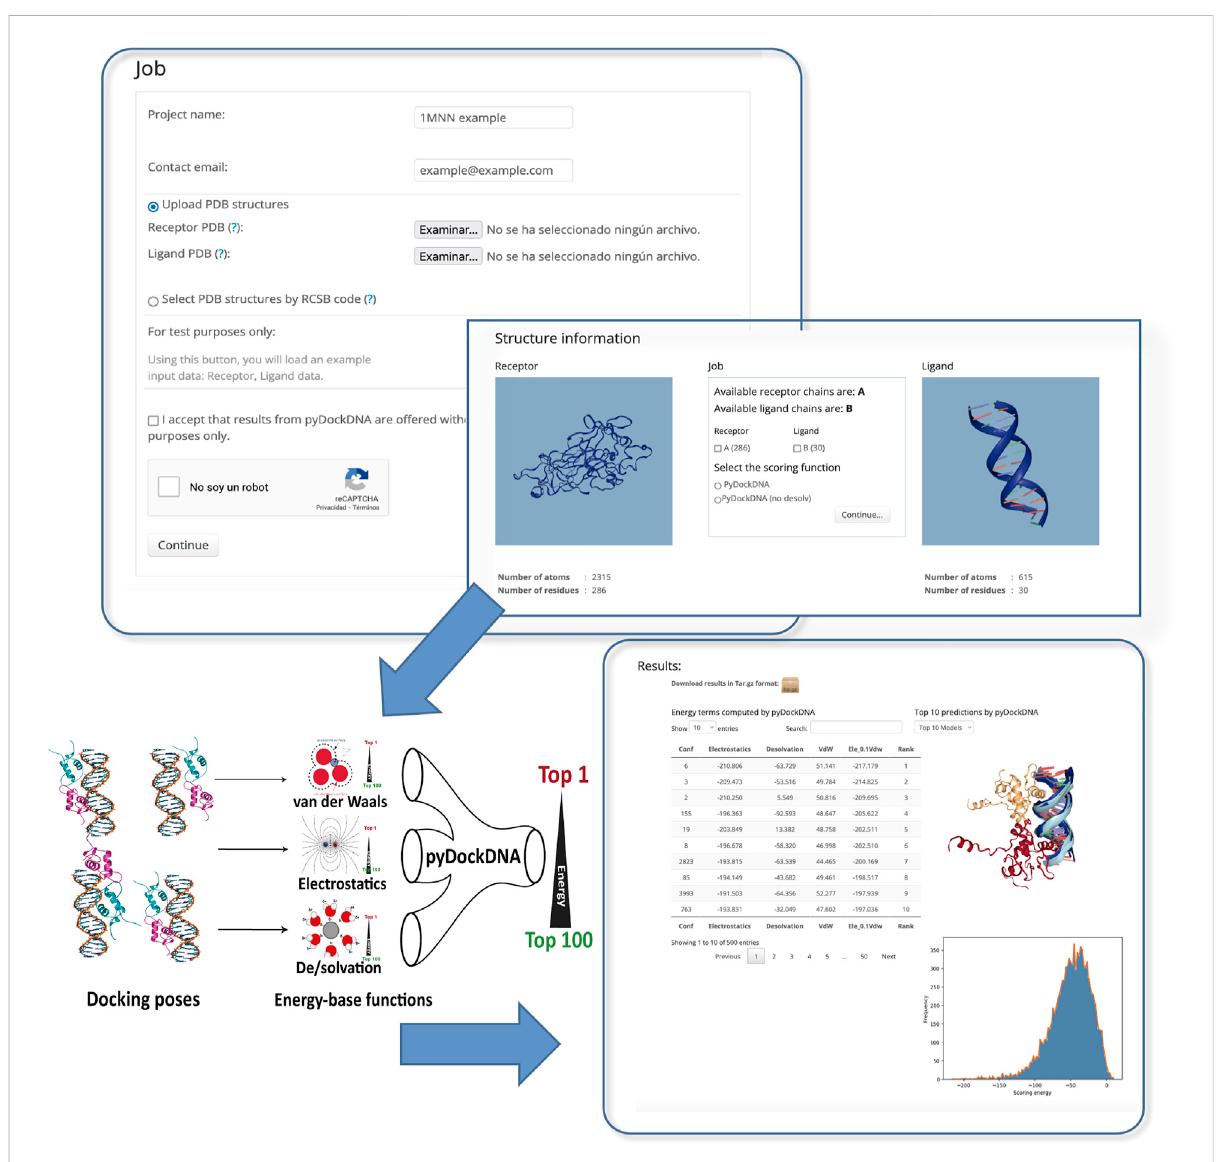
FIGURE 1 Schematic representation of the pyDockDNA web server main